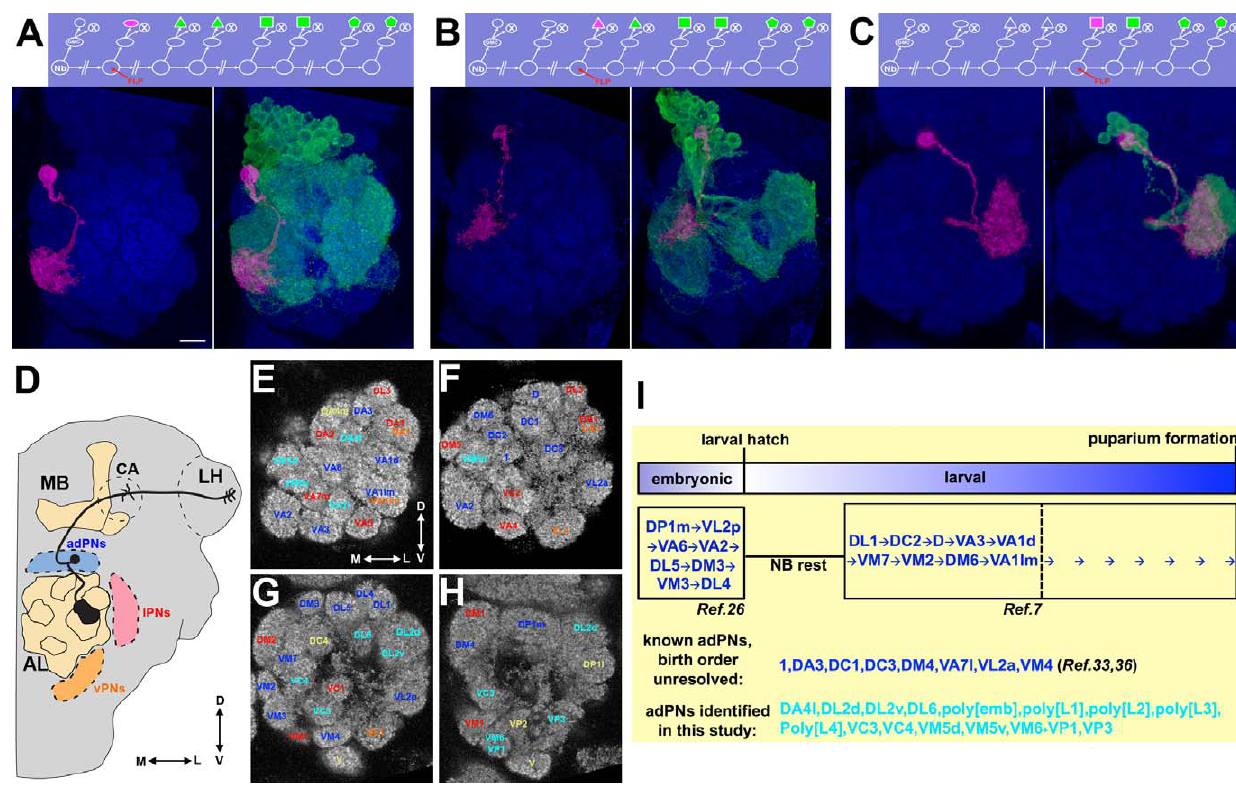
Figure 1. Examples of paired sister clones, the AL glomerular architecture, and a summary of adPNs. (A–C) GMC clones (magenta) pairs with NB clones (green) of different sizes depending on when mitotic recombination occurred in a protracted lineage. Judging from the size of the accompanying NB clone, one can determine when the GMC of a particular neuron was born in the lineage. One can therefore deduce in the adPN lineage: the VM3-targeting neuron (magenta in [A]) born around the beginning, the 1-targeting neuron (magenta in [B]) derived in the middle, and the DL2v-targeting neuron (magenta in [C]) made near the end. (D) A schematic illustration of an uniglomerular adPN (black) that connects one of the 50 or so AL glomeruli with the calyx (CA) of the mushroom body (MB) and the lateral horn (LH). The relative position of three populations of PNs, the adPNs (blue), lPNs (red), and vPNs (orange), is also shown. (E–H) All identifiable glomeruli in the AL are shown in four anterior-to-posterior focal sections. The glomerular targets of previously identified uniglomerular adPNs, lPNs, and vPNs are labeled in blue, red, and orange, respectively. The glomerular targets of the uniglomerular adPNs identified in this study are shown in cyan. And the glomeruli with yellow labels have not yet found their corresponding uniglomerular PNs. (I) adPNs identified previously and in this study are summarized. The adPNs with known birth order are further arranged with respect to the lineage development. Fly brains were counterstained with nc82 mAb (blue) in this and all other figures, which permits determination of glomerular identity in the AL. The scale bar in this and all other figures equals 10 m